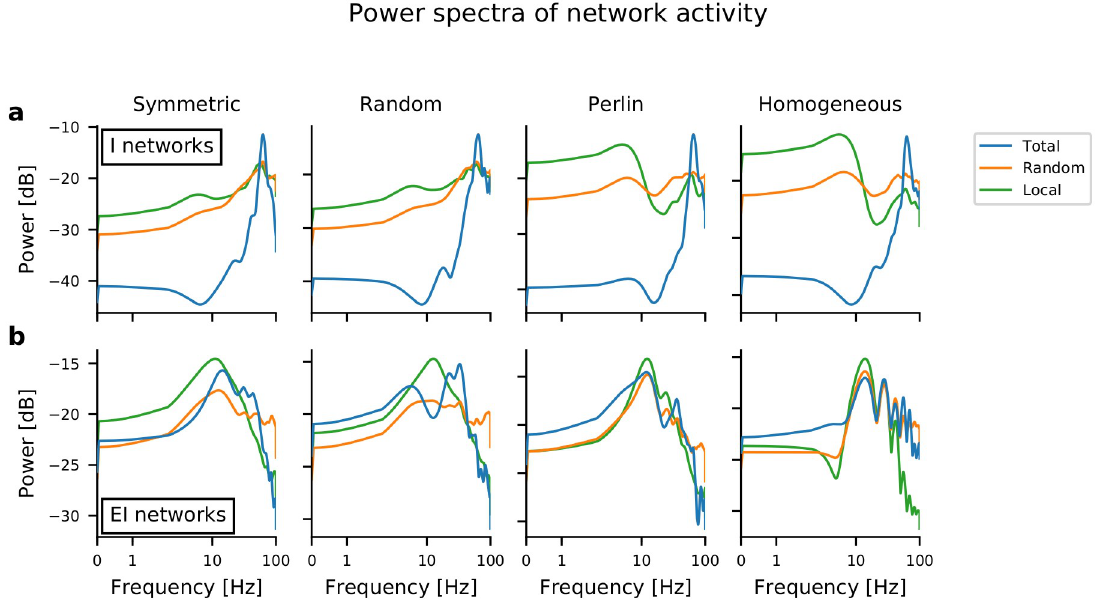
Fig 4. Power spectra of network activity in I-networks and EI-networks in different spatial inhomogeneity configurations. ( a ) Power spectra of summed spiking activities (bin width = 5 ms), with different traces referring to the source of the data: the z-score of the spiking activity of the entire network population (blue trace), of 100 randomly selected neurons from the entire network (orange trace), and of the neurons located in a 10 × 10 region in the network (green trace). The power spectrum in all I-network models peaked at approx. 60 Hz (gamma-band oscillations). Additionally, in network models with homogeneous and Perlin configurations, an additional, weak low- frequency peak, at around 3-4 Hz, appeared. ( b ) Same as in a for EI-networks. Low-frequency peak around 12-14 Hz were observed in networks with homogeneous and Perlin